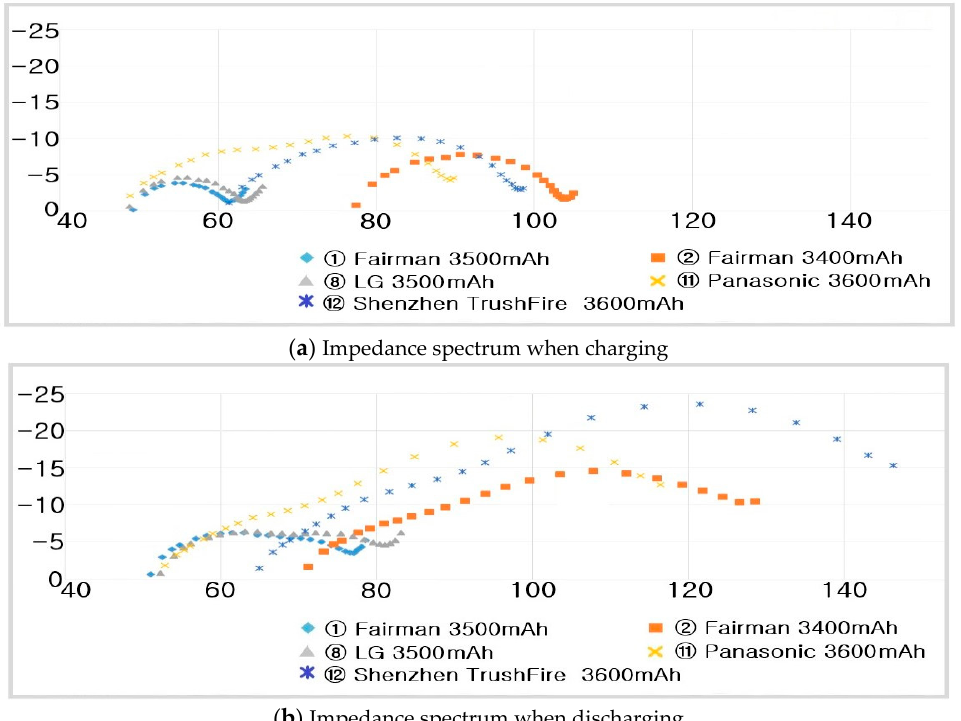
Figure 19. Impedance spectra of 18650-type (cylindrical 3400–3600 mAh) Li-ion batteries (built-in protection device).